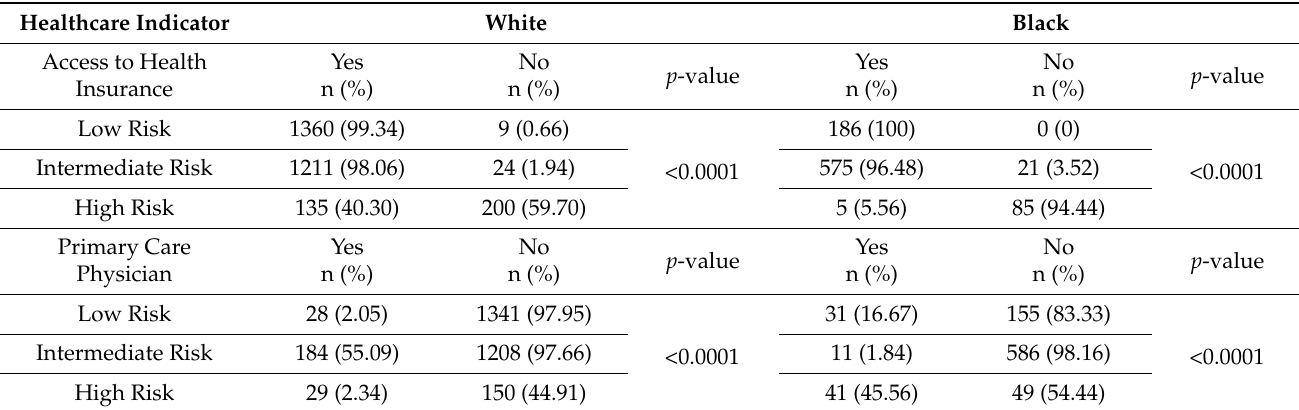
Table 2. Classification frequencies of limited healthcare indicators for Black and white Alabamians with COPD, BRFSS, 2015–2019. White Black